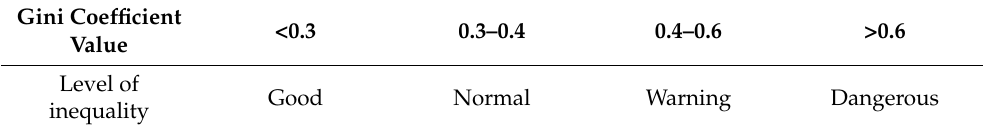
Table 1. Criteria of Gini